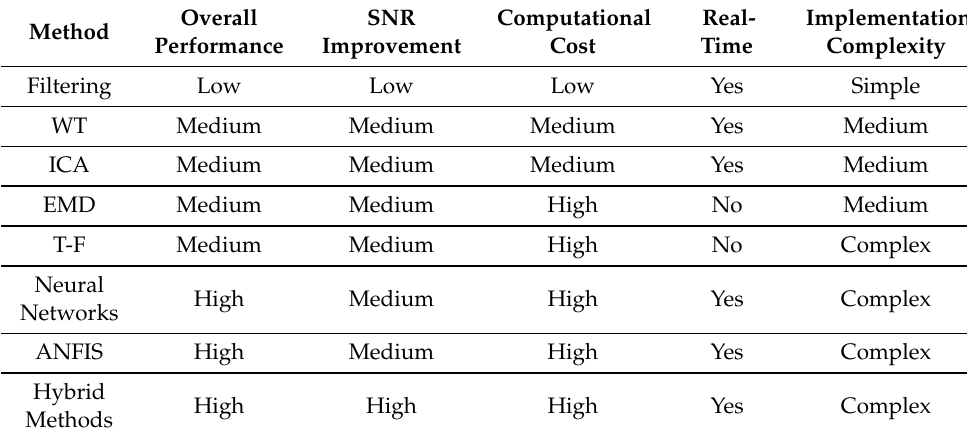
Table 1. Summary of the EEG signal processing methods.